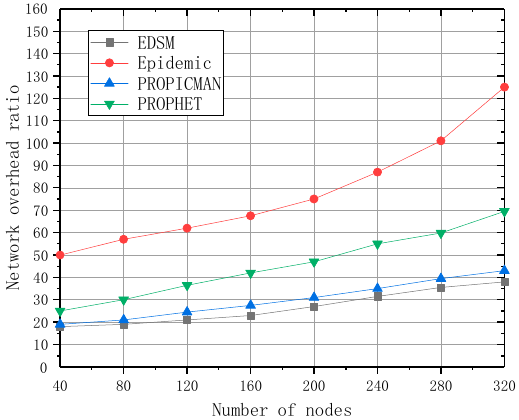
Figure 6. Network overhead ratio under different number of nodes.